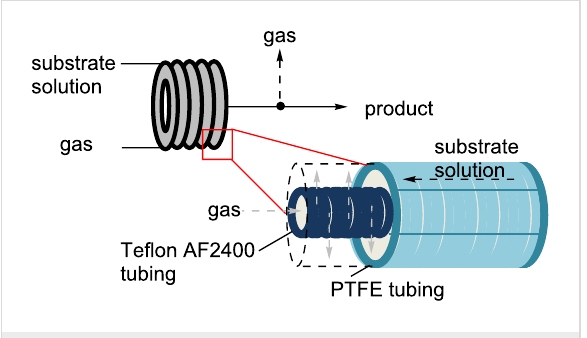
Figure 3: Schematic representation of the ‘tube-in-tube’